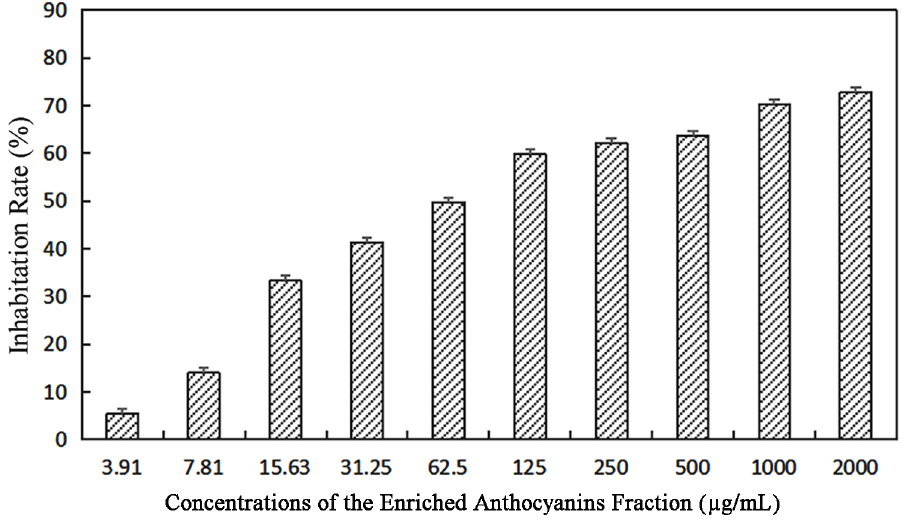
Figure 5. Effect of different concentrations of the enriched anthocyanins fraction on the viability of BGC-803 cells for 48 h (3.91–2000 µ